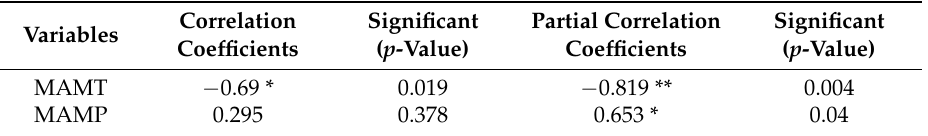
Table 2. Correlations between vegetation cover changes and climatic factors. Correlation Significant Partial Correlation Significant Variables Coefficients ( p -Value) Coefficients ( p -Value) MAMT − 0.69 * 0.019 − 0.819 ** 0.004 MAMP 0.295 0.378 0.653 * 0.04 * Significant at p < 0.05, ** Significant at p < 0.01.